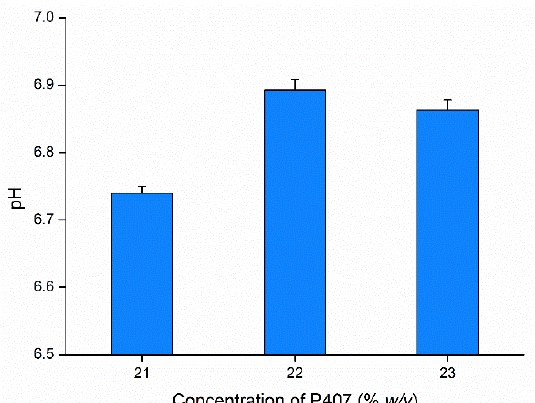
Figure 4. pH of optimized in situ gelling nasal formulations. Data are presented as means ± SD, n = 3.